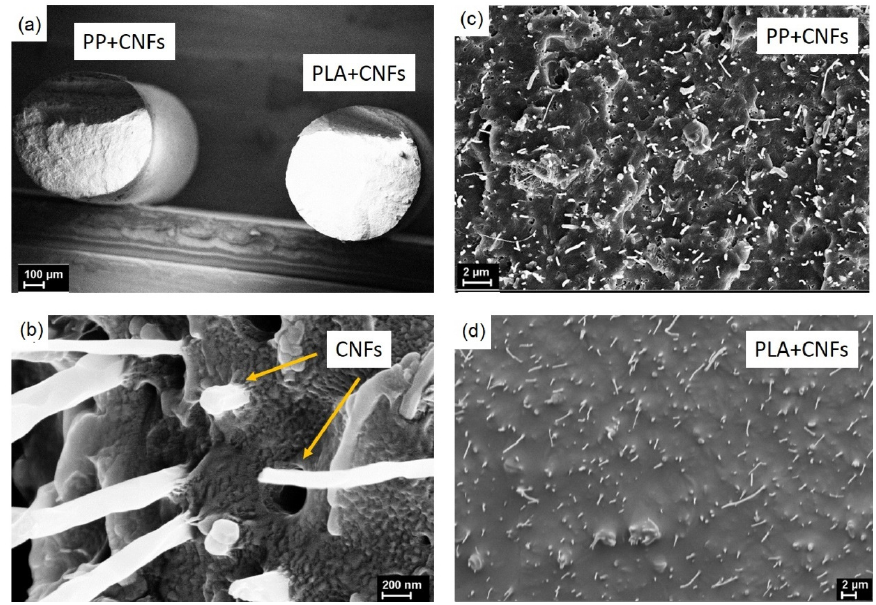
Figure 1. SEM images of the transversal cryo-cleaved of the PP-based and PLA-based composite fibers filled with 10 wt.% CNFs at different scales ( a , c , d ), of PP transcrystallites formed around the nanofillers ( b ).